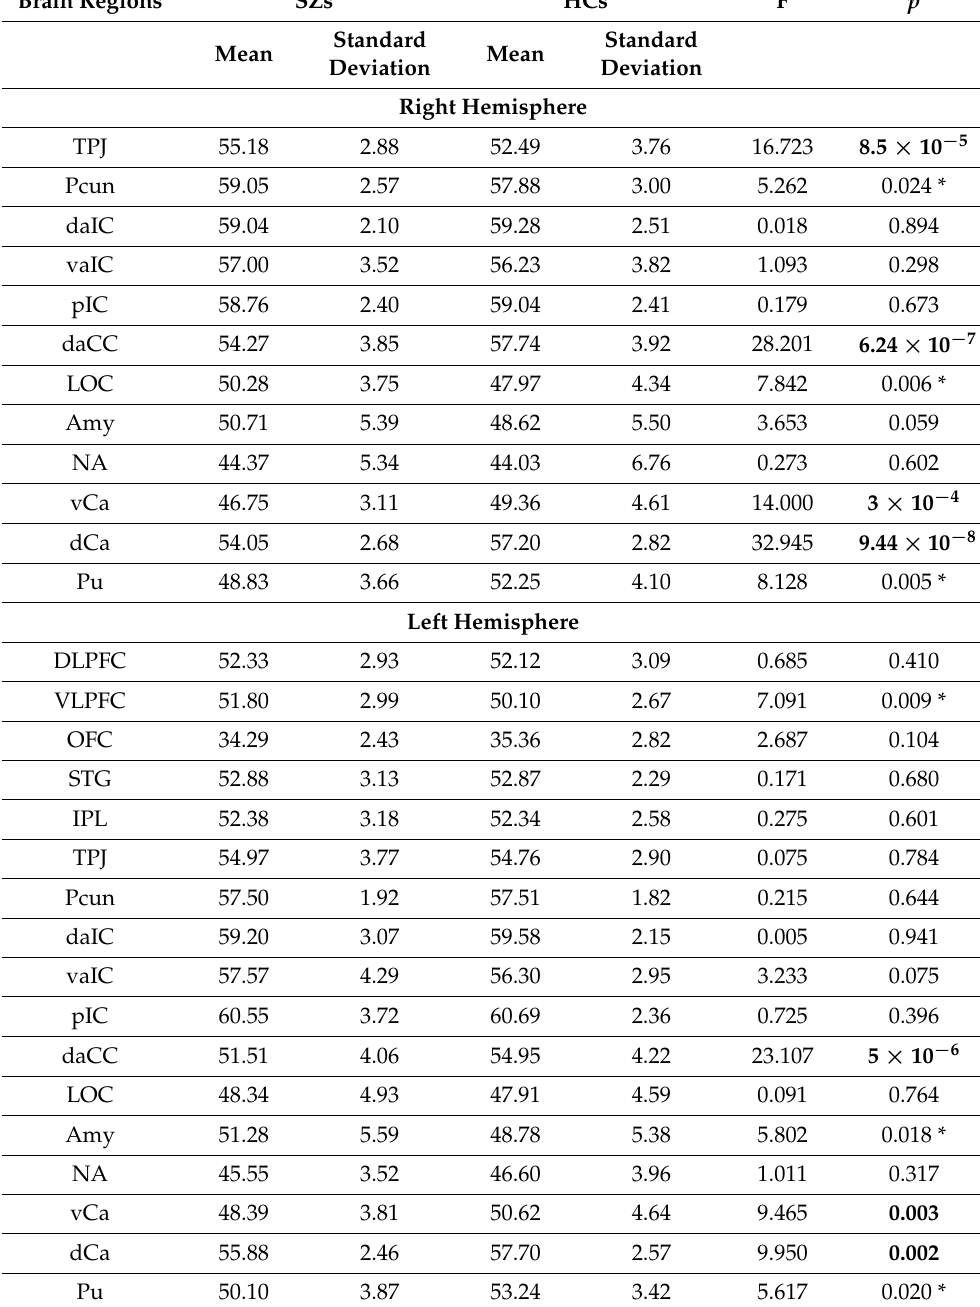
Table 2. Cont. Brain